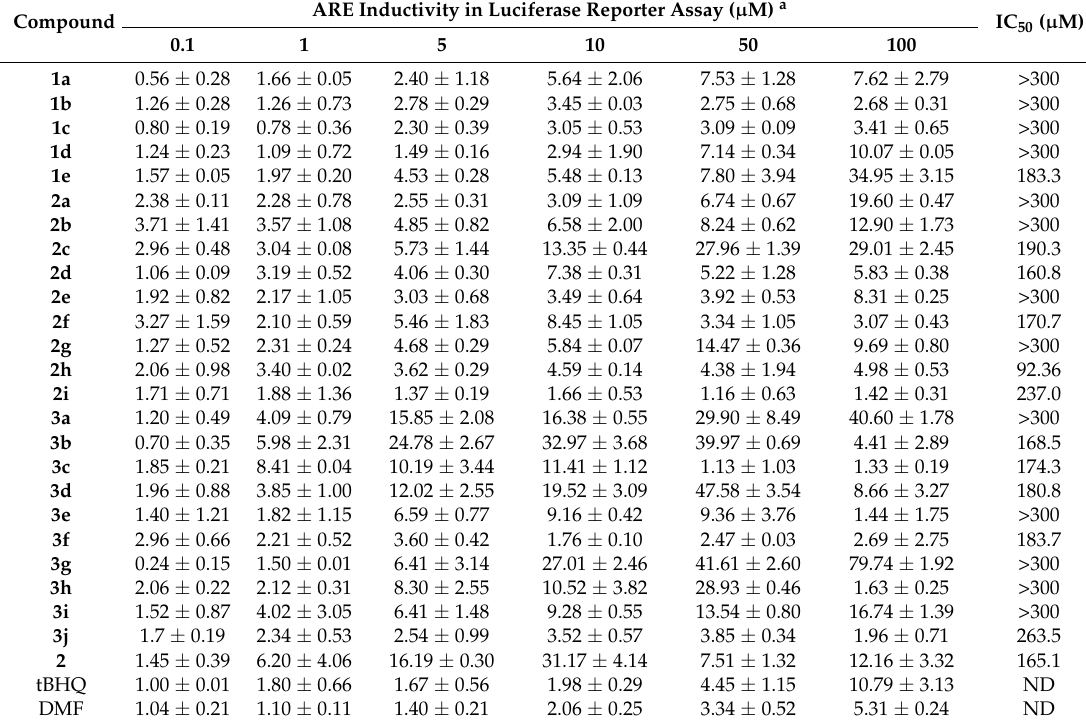
Table 1. Induction fold of antioxidant response element (ARE) activity in HepG2-ARE-C8 cell and IC 50 value measured in HCT116 cells of Series I, II and III compounds. Compound